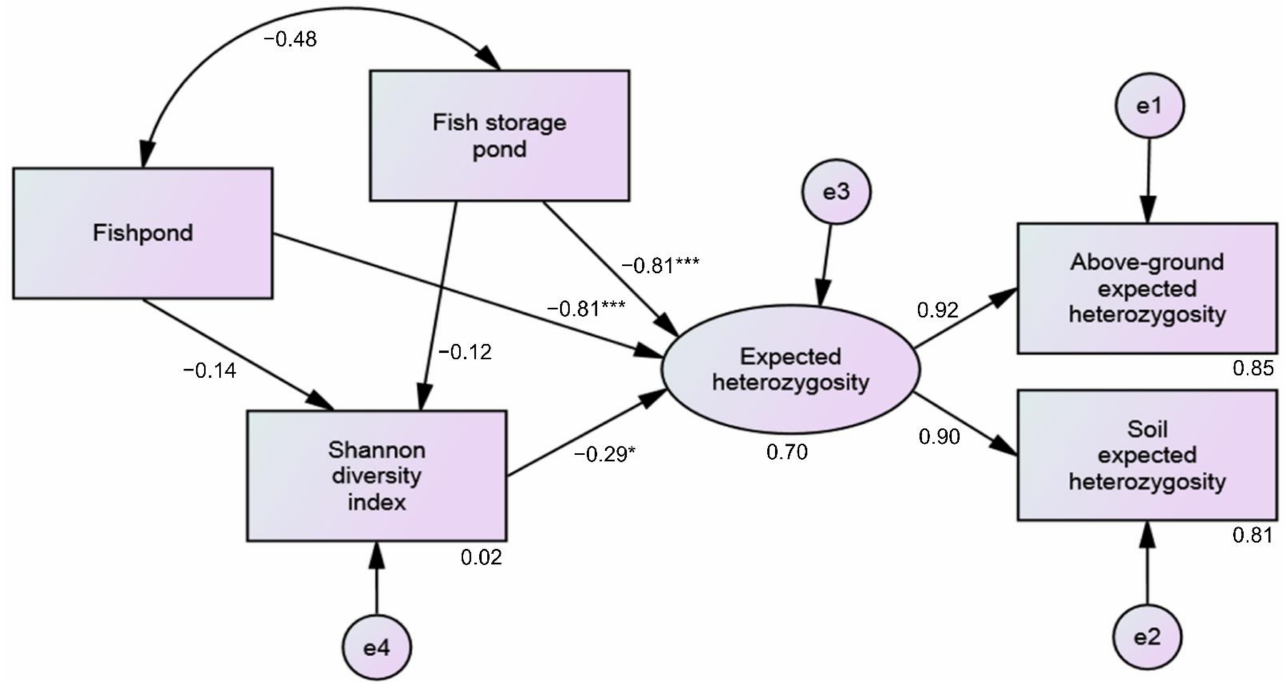
Figure 5. Standardized solution of the structural equation model investigating the effect of Shannon diversity ( H ) on average expected heterozygosity ( H S ) in consideration of the direct and indirect effects of the third variable habitat type (river = reference, n = 31). Measures of model fit: χ 2 = 5.057, χ 2 /df = 2.528, RMSEA = 0.226, TLI = 0.778. Significance codes: * <0.050; *** <0.001.